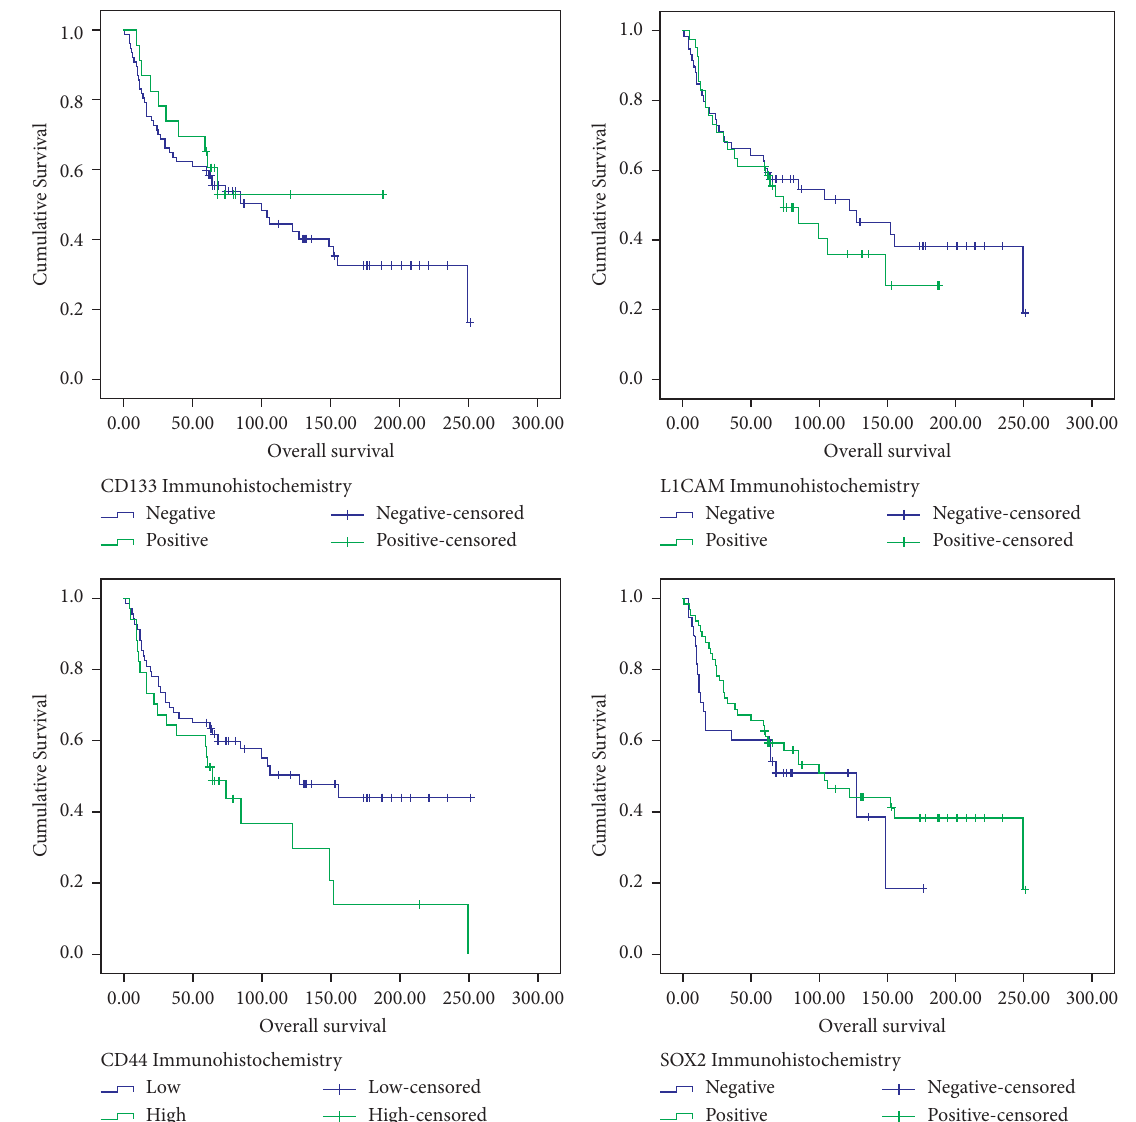
Figure 2: Kaplan–Meier curve analysis for overall survival of OSCC patients with P � 0 . 613 for CD133 expression, P � 0 . 047 for CD44 expression, P � 0 . 489 for L1CAM expression, and P � 0 . 318 for SOX2